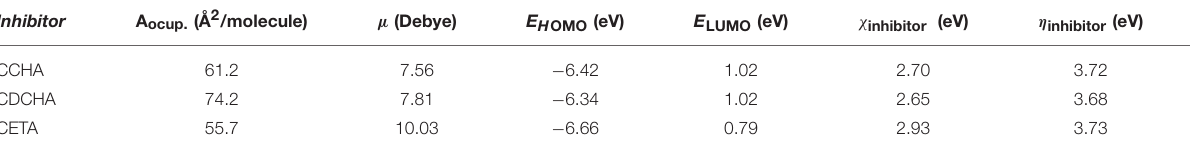
TABLE 1 | Quantum-chemical parameters calculated for the VCI interaction with zinc. Inhibitor A ocup. (Å 2 /molecule)